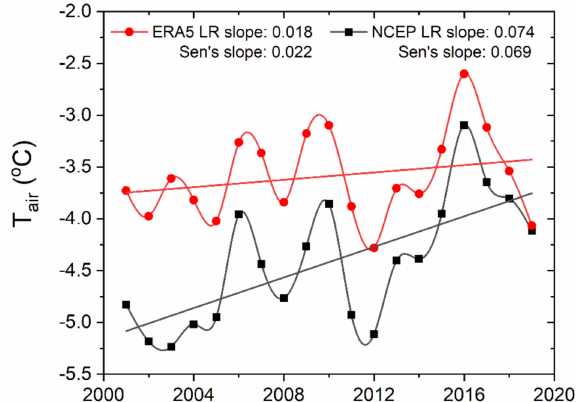
Figure 10. The temporal trend of air temperature at 2 m height was obtained from ERA5 and NCEP. Each point represents the aerial average of mean annual value over TP. straight lines are LR slope values. Both LR slope and Sen’s slope were computed at a 95% confidence level.